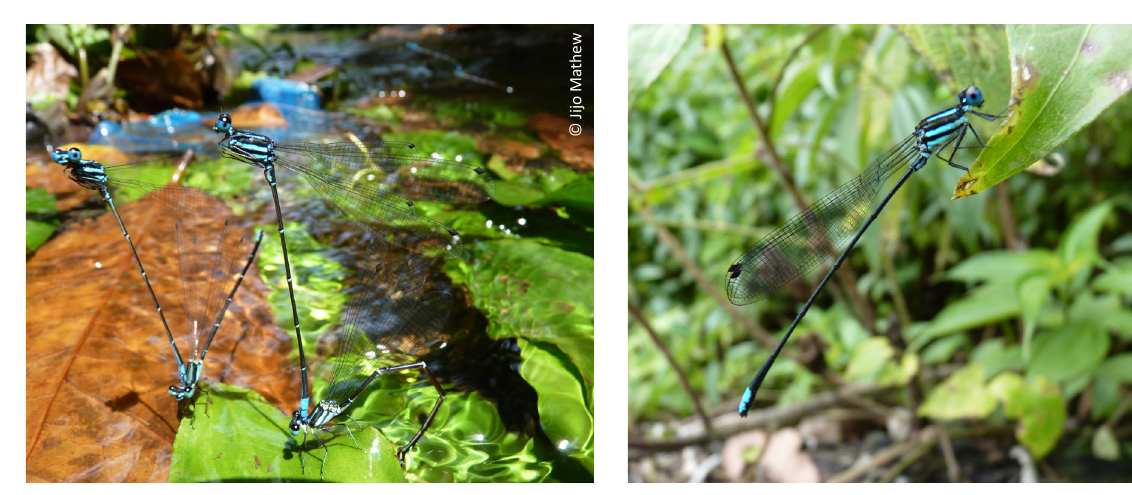
Image 20. Esme mudiensis Image 19. Esme longistyla